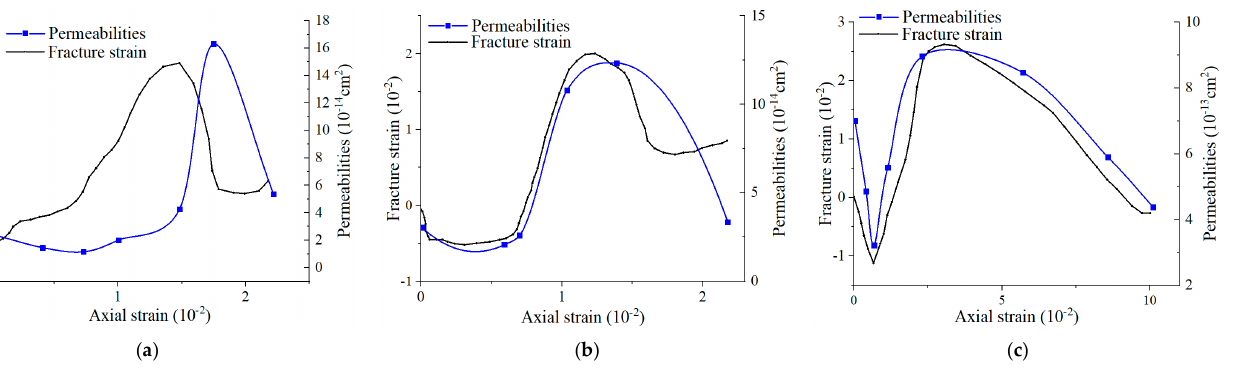
Figure 6. Volumetric strain and permeability curves of rock fracture under mining-induced stress path. ( a ) mudstone fracture strain; ( b ) Fracture strain of sandy mudstone; ( c ) sandstone fracture strain.